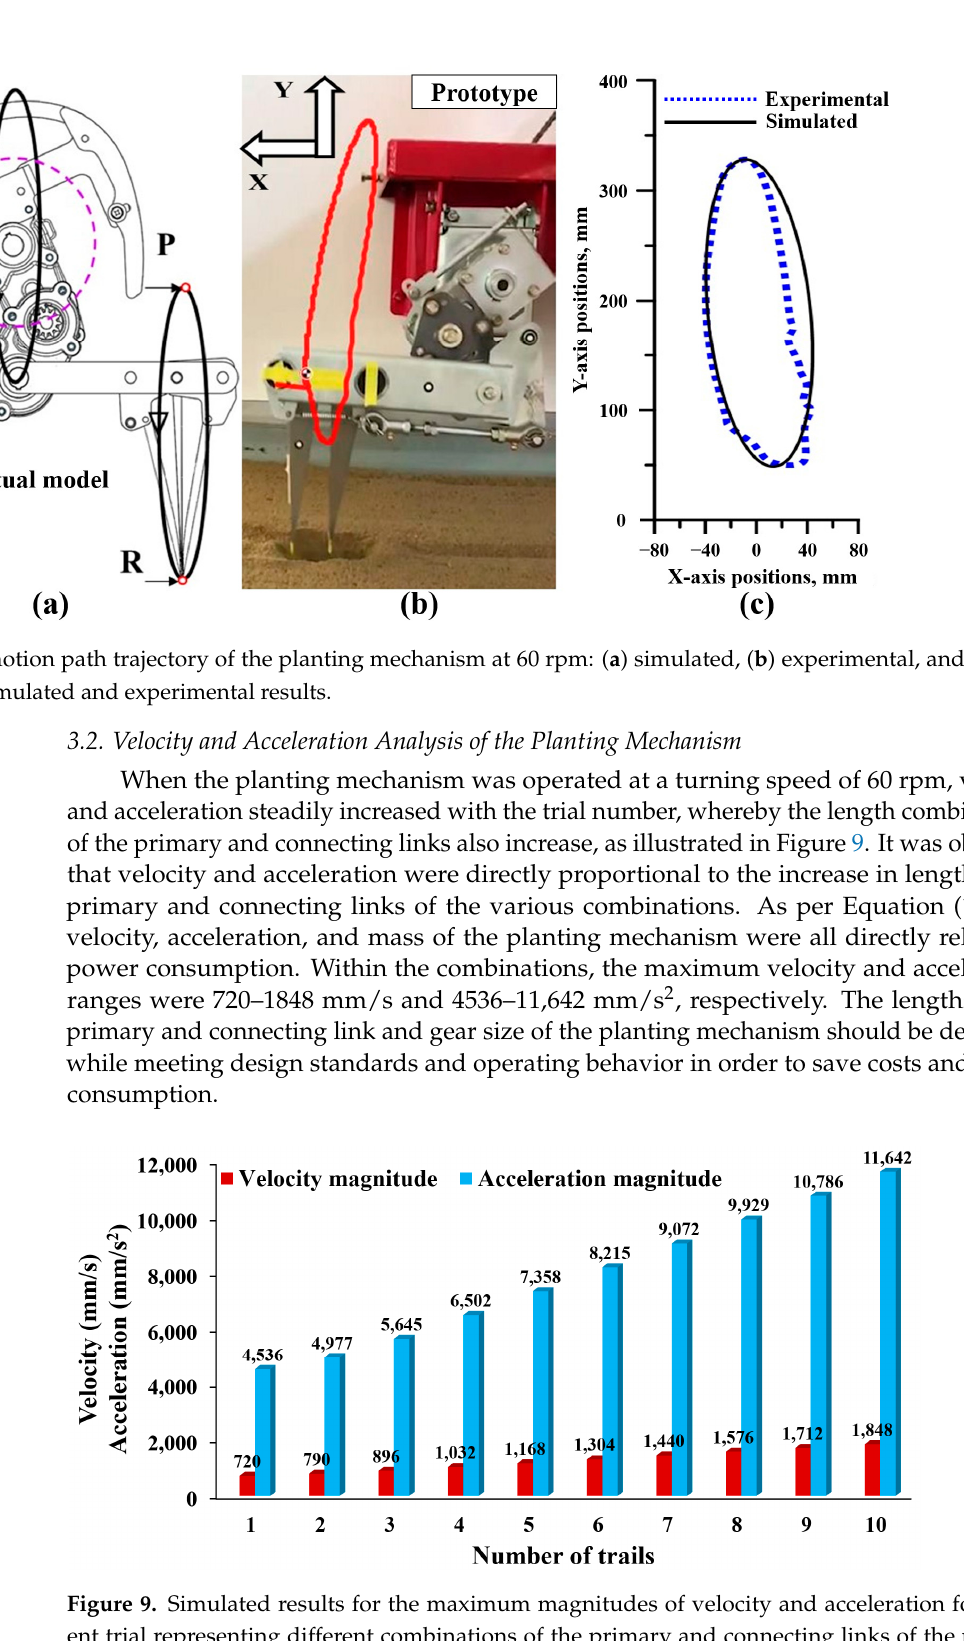
11 of 17 Figure 7. Motion trajectory of rotary planting mechanism in different combinations of primary and connecting links. The oval or elliptical motion path was derived from the trajectory of different rota-